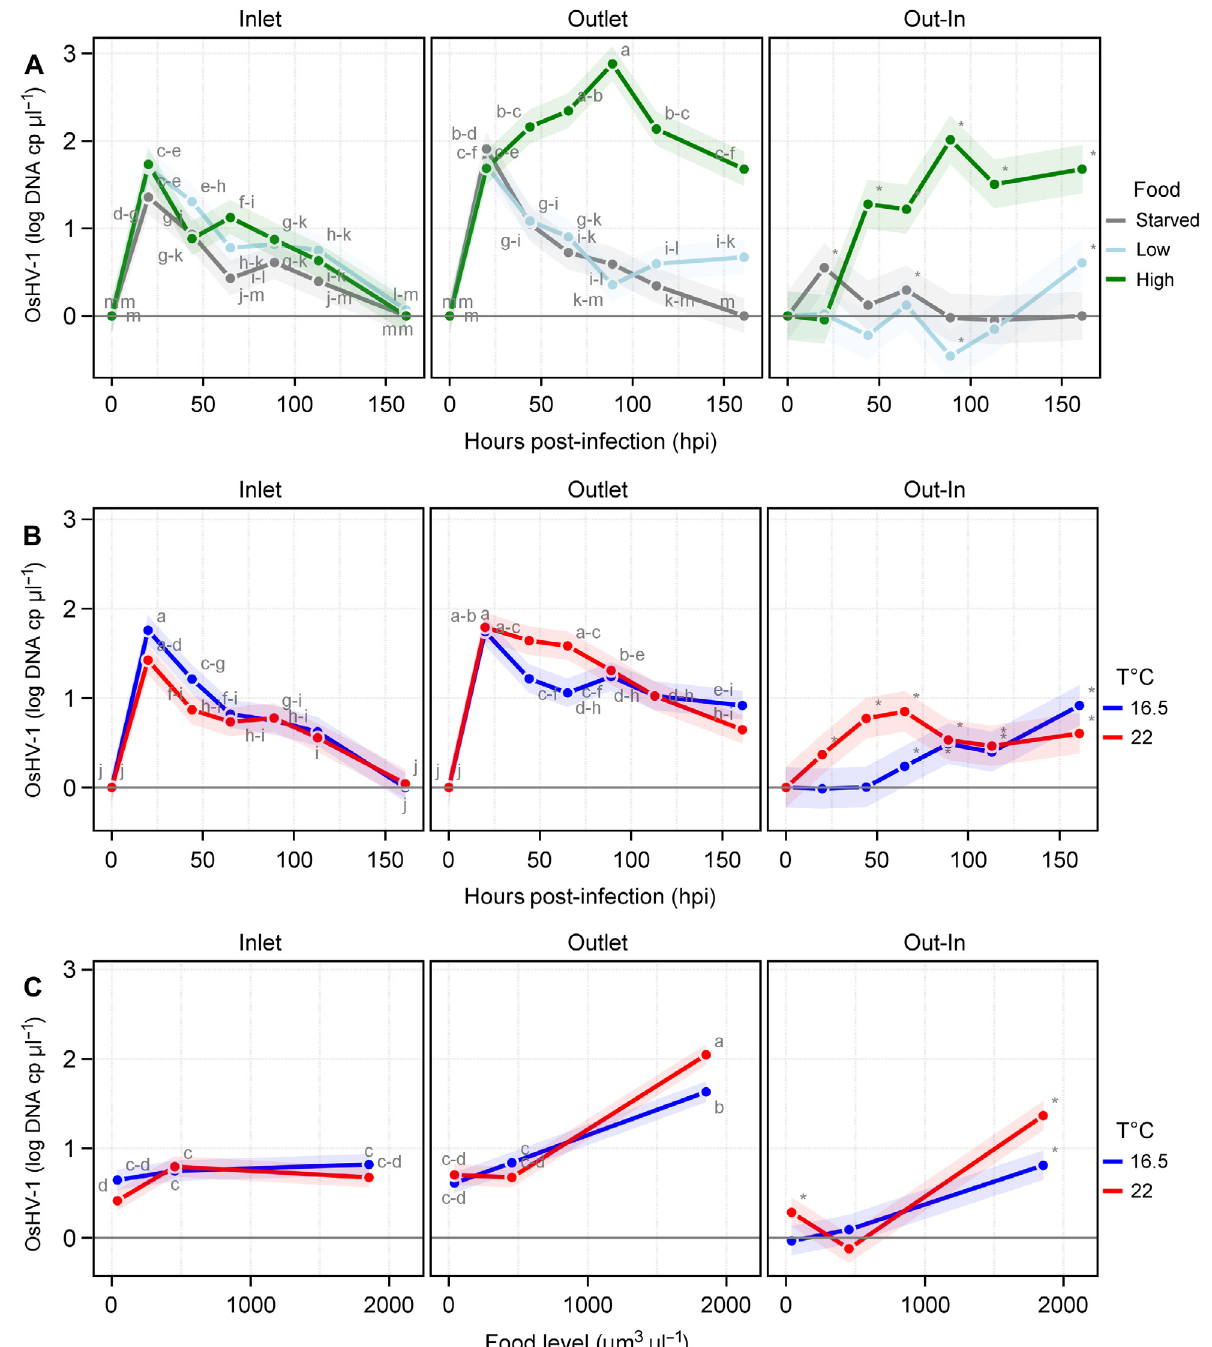
Fig. 5. Levels of OsHV-1 DNA in seawater. Data are means ± 95% confidence intervals (n = 6 tanks for food or temperature ef- fect and n = 3 tanks for temperature × food). Interactions of (A) food and time, (B) temperature and time and (C) temperature and food. Data were measured at the inlet (left column) and outlet (centre column) of the tank. Lowercase letters indicate significant differences. Pairwise comparisons between the outlet and the inlet are represented in the right column (asterisks indicate statistical significance at α = 0.05). Food levels reported on the x -axis corresponded to starved, low and high